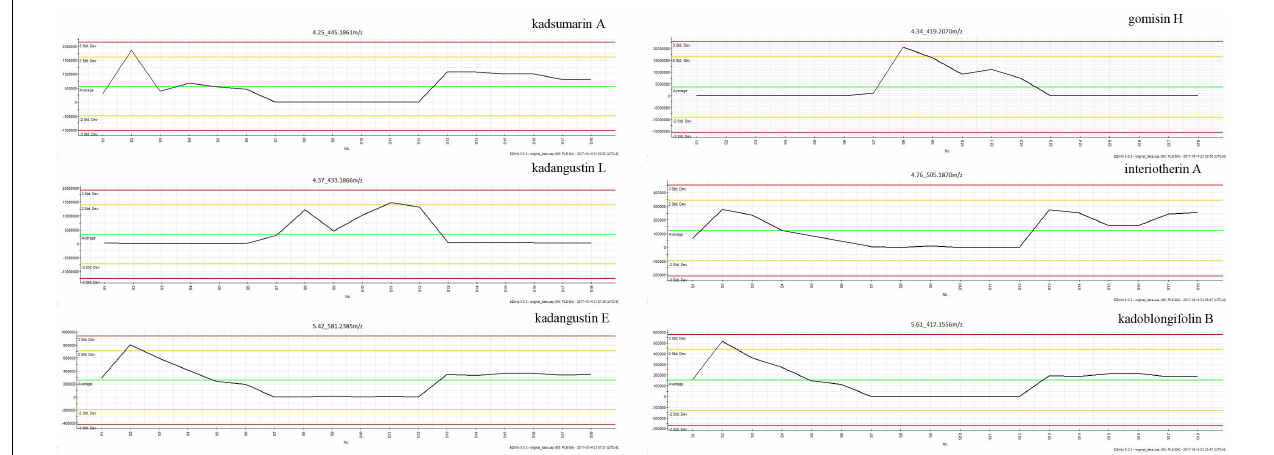
FIGURE 6 | The ion intensities of